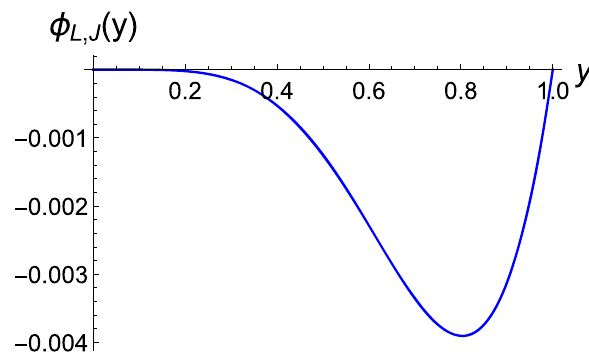
to decelerating contraction. One cycle ends and the next cycle